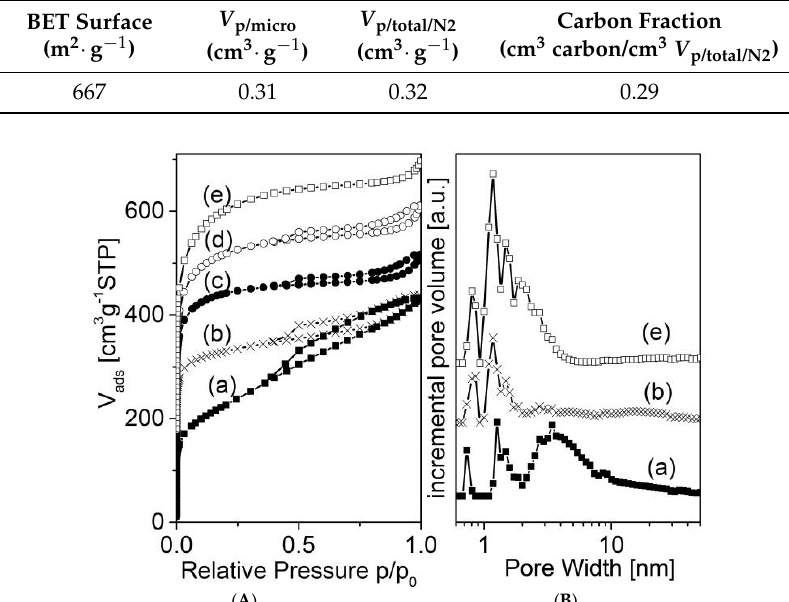
Table 4. Textural data of the zeolite tube.